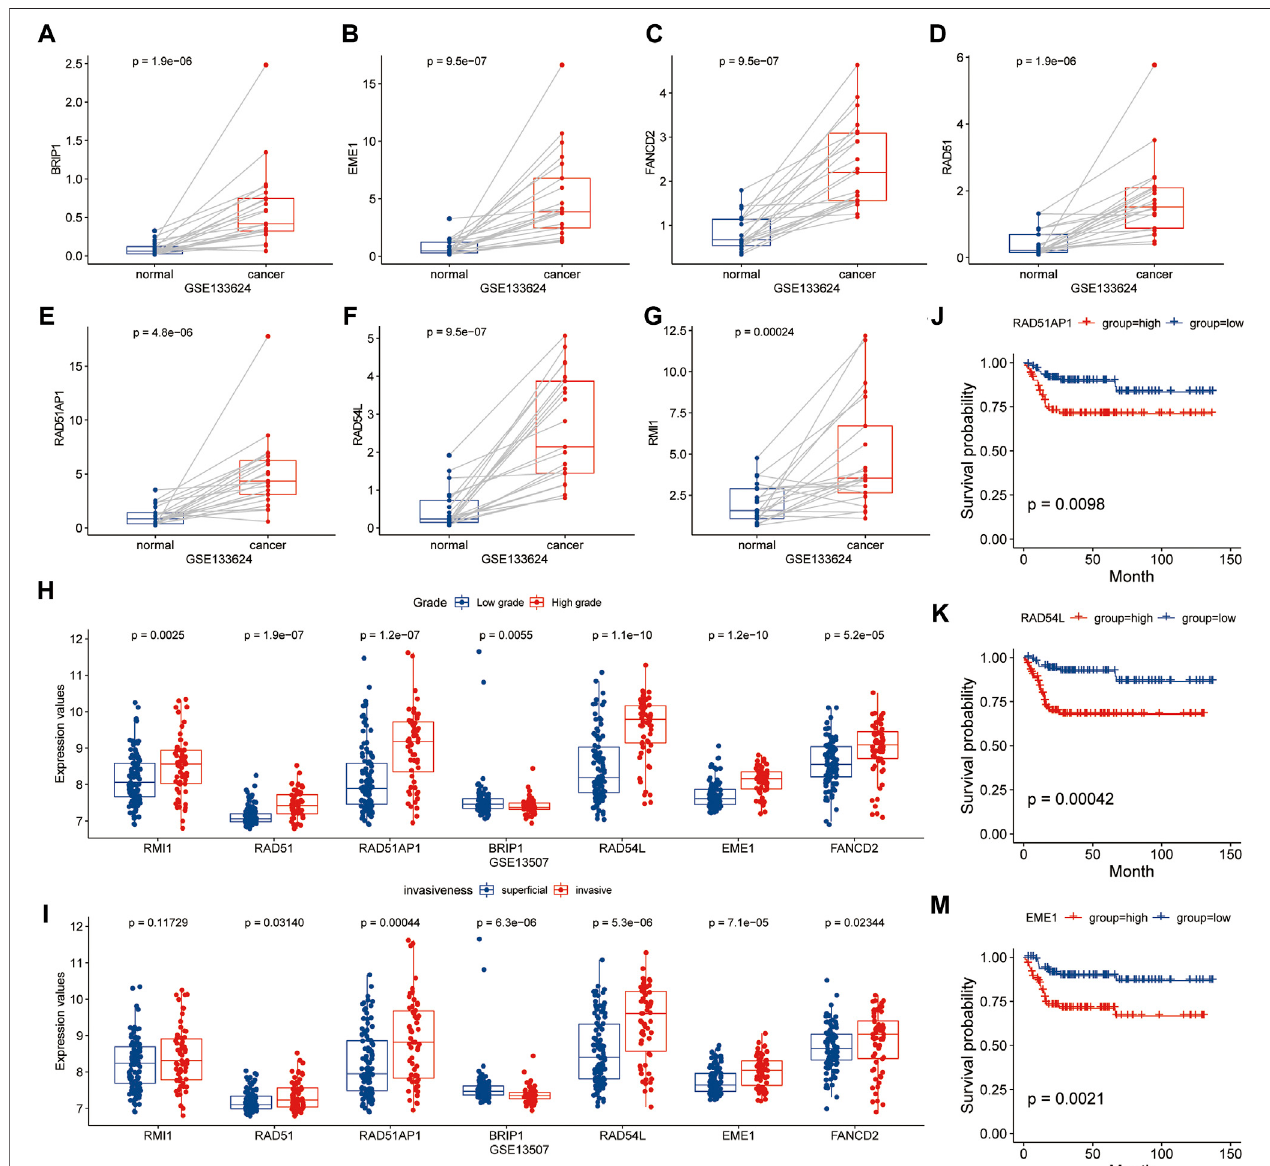
FIGURE 9| Analysis ofrelationship betweenHR related genesand clinical features in GSE133624 and GSE13507. (A – G) , Differences in expression ofHR-related genesbetweencancerandpairedparacancersamples; (H,I) ,ExpressiondifferencesofHRrelatedgenesindifferenttumorgradesandinvasivesamples; (J – M) ,Kaplan- Meier survival analysis based on grouping of median expression values of HR related genes in